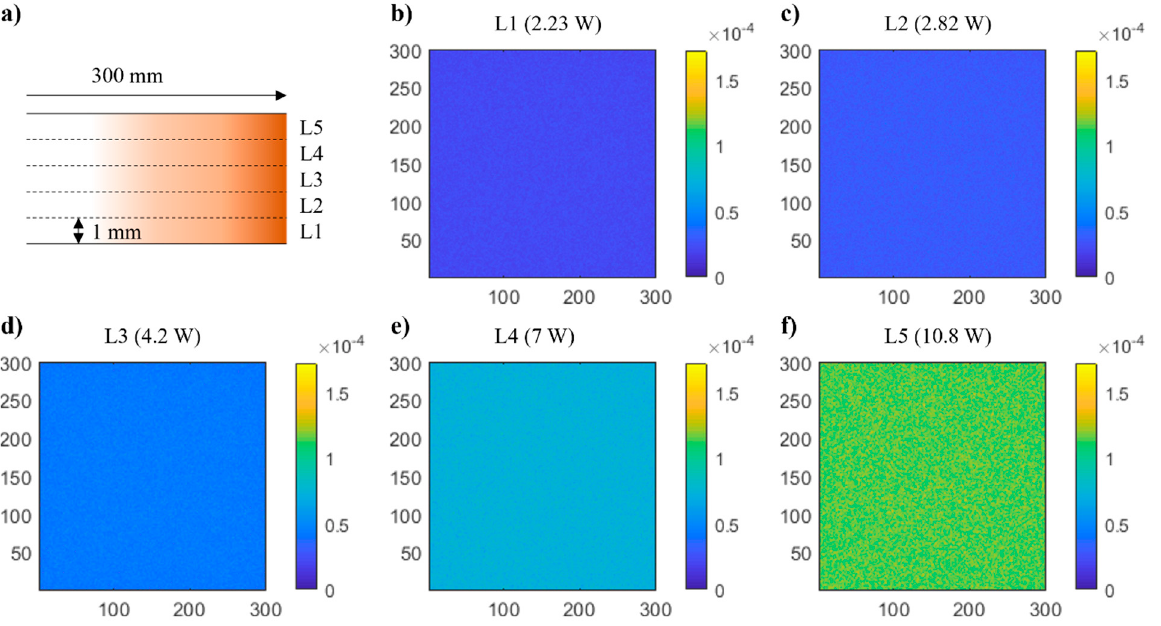
Figure 3. ( a ) Layer configuration of the LSC, and ( b – f ) heat maps of the layers (color bars with the unit of W).